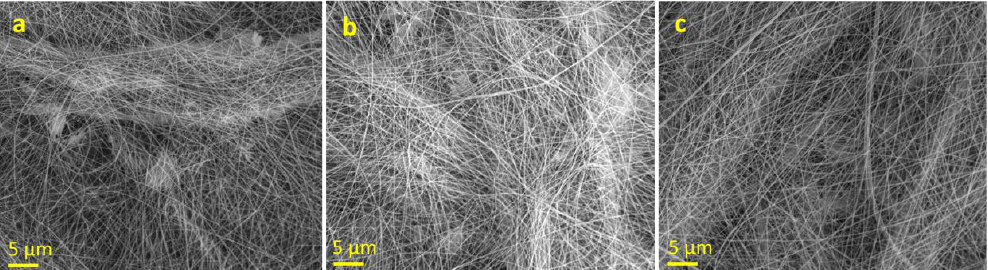
Figure 7. SEM images of PLA/PEO (9:1) — AgNPs fibers (4.0 wt.% Ag): ( a ) PLA/PEO 7.5 wt.%, 0.5 mL/h; ( b ) PLA/PEO 7.5 wt.%, 0.3 mL/h; ( c ) PLA/PEO 8.5 wt.%, 0.5 mL/h. Average fiber diameters are: ( a ) 0.21 ± 0.06 µm; ( b ) 0.18 ± 0.04 µm; ( c ) 0.15 ± 0.06 µm.